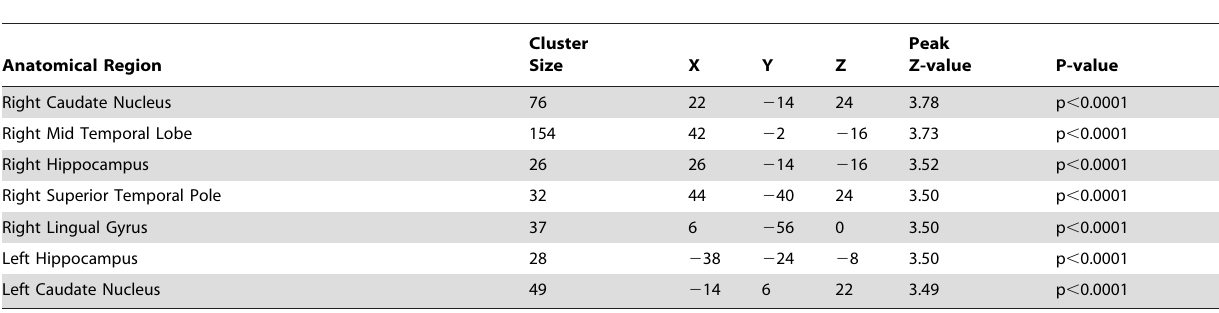
Table 3. Representation of cerebral activation when contrasting HC . FM for incongruent . congruent stimuli.